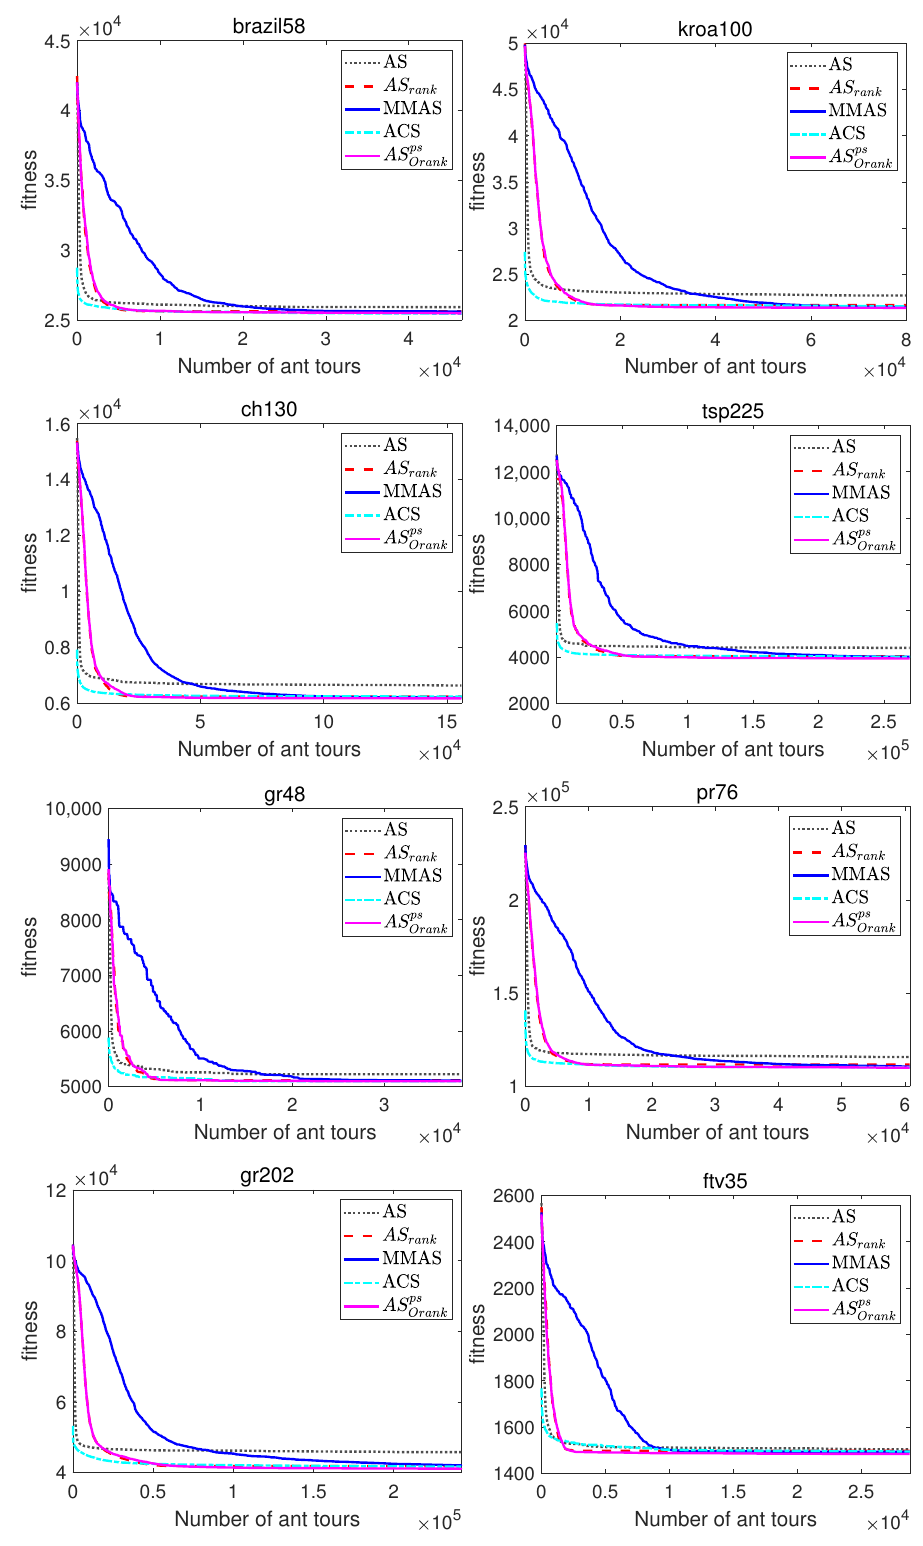
Figure 6. Evolutionary curves of ACO algorithms for symmetric and asymmetric TSP